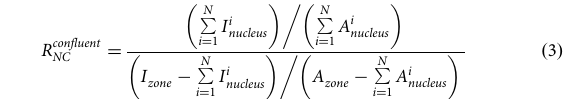
Fig. 8b, Supplementary Fig. 9c, Supplementary Fig. 10b, Supplementary Fig. 11, Supplementary Fig. 12b, Supplementary Fig. 13b, Supplementary Fig. 14b-e are provided with this paper. All other relevant data supporting the key fi ndings of this study are available within the article and its Supplementary Information fi les or from